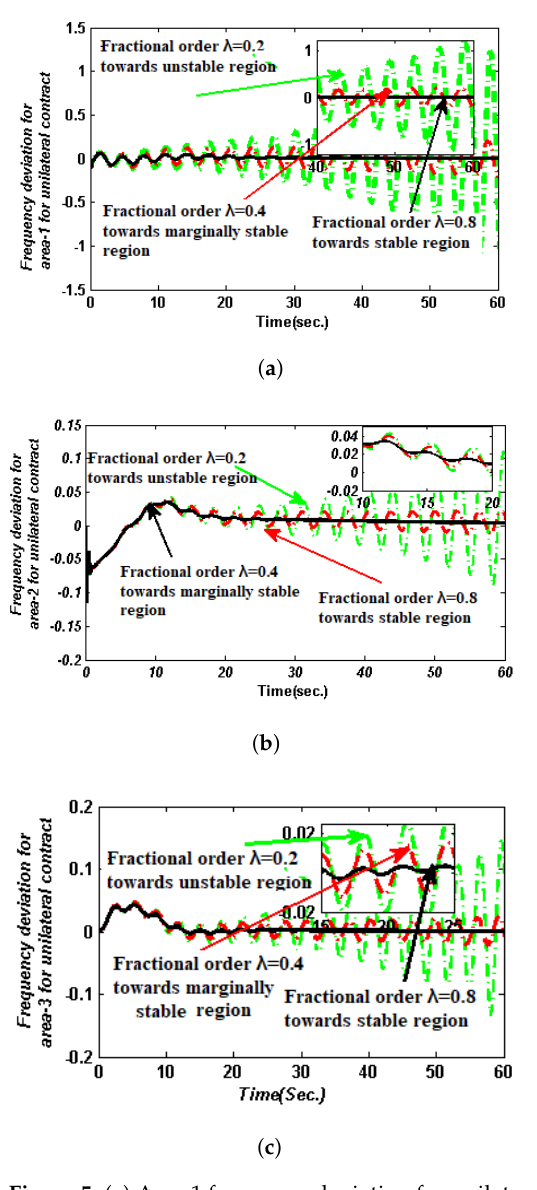
Figure 5. ( a ) Area 1 frequency deviation for unilateral condition with 10% SLP type of load distur- bance with time − varying delay τ d = 6.102 s . at a rate of µ = 0.0. ( b ) Area 2 frequency deviation for unilateral scenario with 10 % SLP type of load with time − varying delay τ d = 6.102 s . at a rate µ = 0.0. ( c ) Area 3 frequency deviation for for unilateral scenario with 10 % SLP type of load with constant time delay τ d = 6.328 s. at a rate µ =